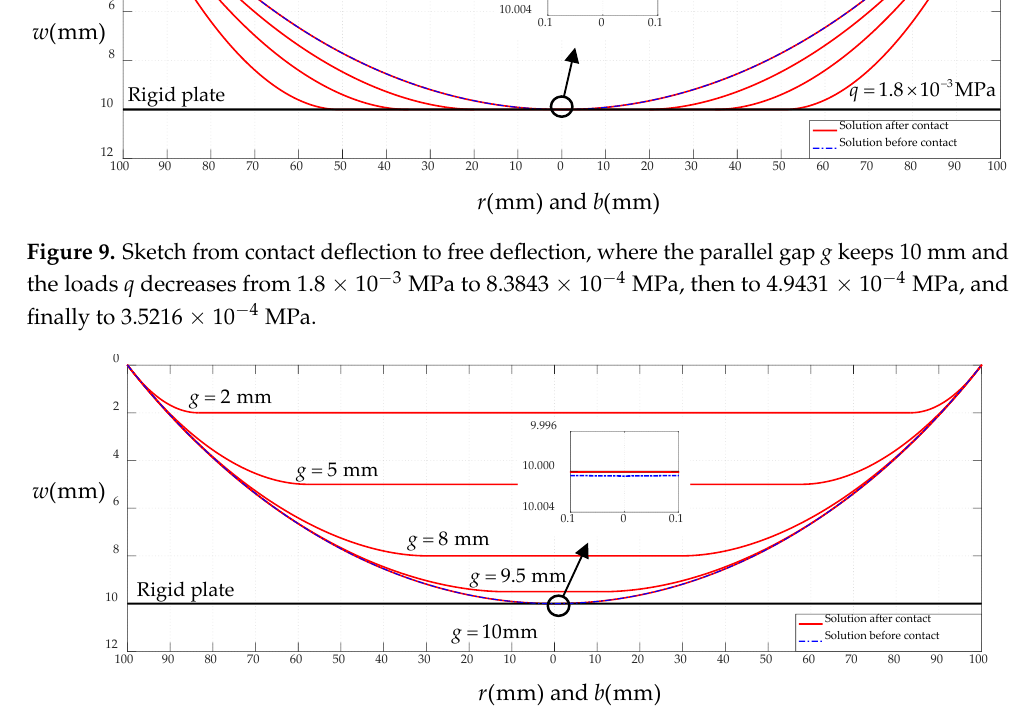
Figure 10. Sketch from contact deflection to free deflection, where the loads q keeps 3.5216 × 10 −4 MPa and the parallel gap g increases from 2 mm to 5 mm, then to 8 mm, then to 9.5 mm, and finally to 10 mm.